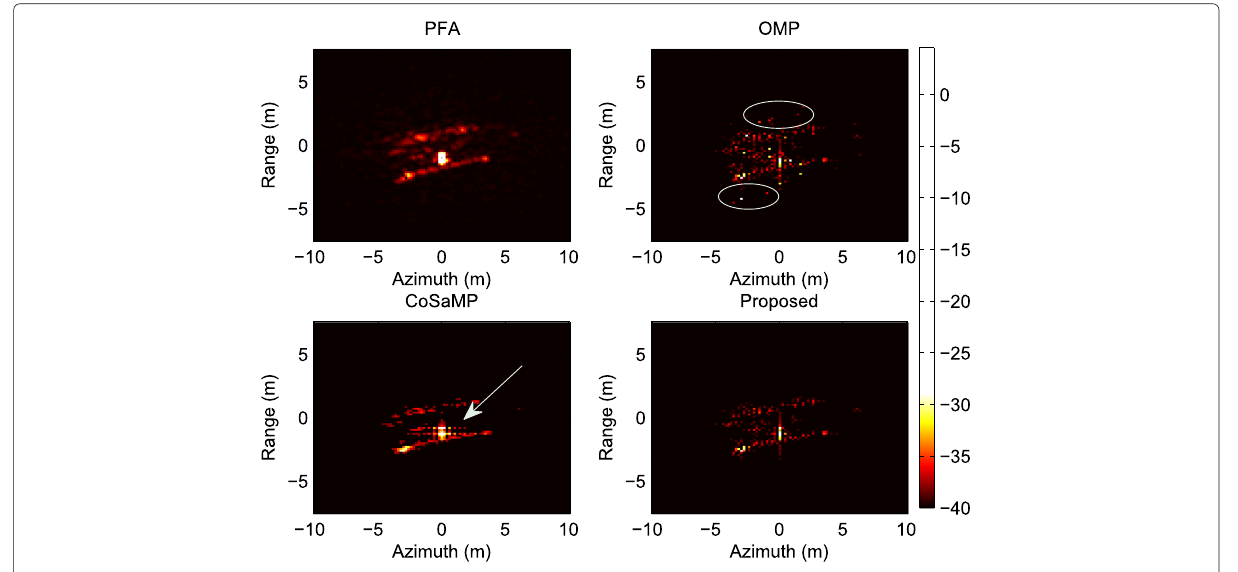
Fig. 6 SAR imaging for practical measured data, φ = 100